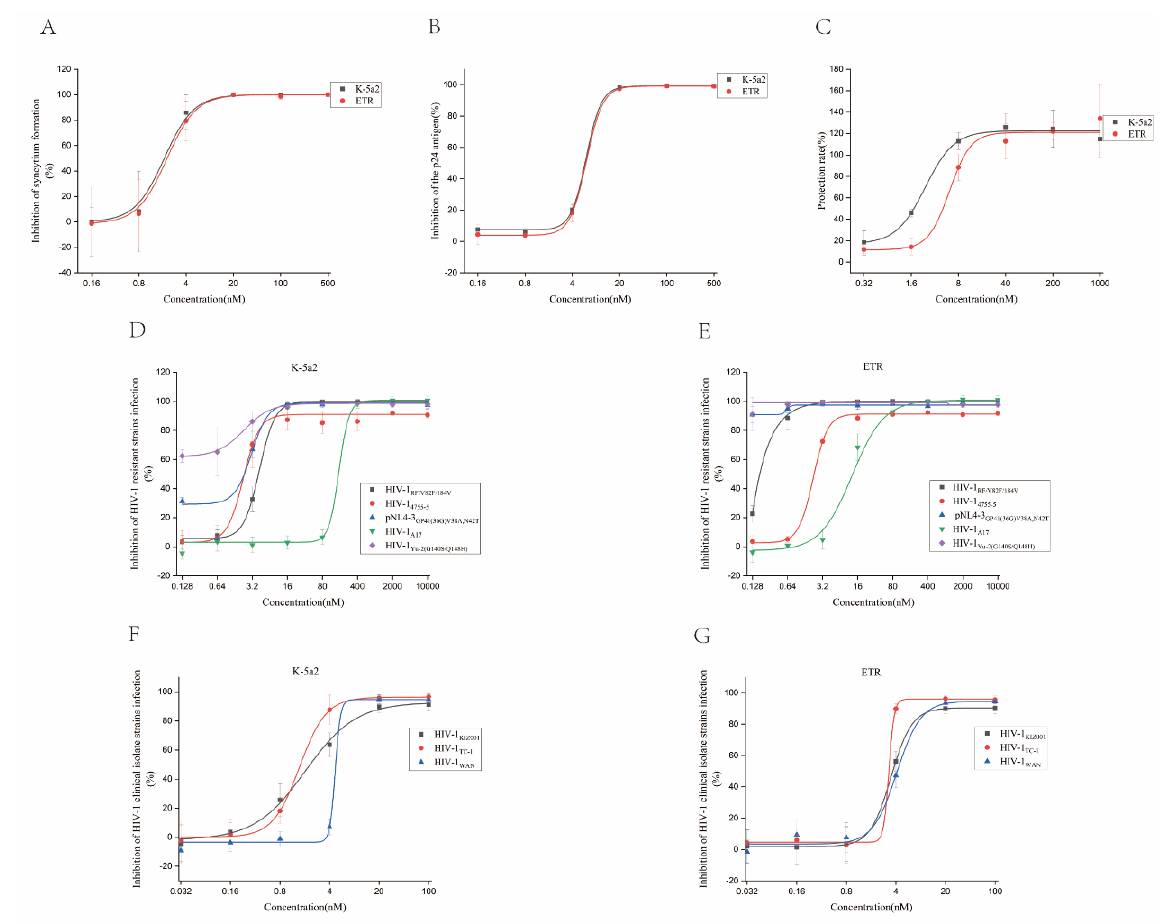
Figure 4. Antiviral properties of K-5a2. C8166 cells infected with HIV-1 IIIB and compounds were co-cultured for three days. The cytopathic effect was tested by counting the number of syncytia under an inverted microscope ( A ). Supernatants were collected at three days post-infection and p24 in the culture supernatant was analyzed by ELISA assay ( B ). The protective effects of the compounds on MT-4 cells were detected by MTT assay seven days after infection ( C ). The inhibitory effects of K-5a2 ( D ) and ETR ( E ) on HIV-1-resistant strains. C8166 cells infected by resistant strains were treated with gradient-diluted drugs for four days and p24 in the cell culture supernatants was detected by ELISA assay. The inhibitory effects of K-5a2 ( F ) and ETR ( G ) on HIV-1 clinical isolate strains. PBMCs infected by HIV-1 clinical isolates were treated with gradient-diluted drugs for seven days and cell culture supernatants were collected for p24 ELISA assay.